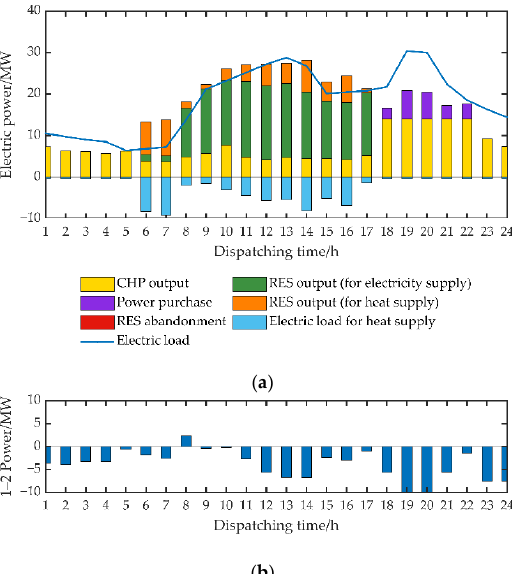
Figure 12. Dispatching strategy of the commercial area under joint dispatching: ( a ) Electric power of the commercial area; ( b ) Electric power of the tie line. The joint dispatching of the office area is shown in Figure 13, which is similar to that the office area is significantly reduced compared with that under independent dispatch- ing, and there is only a small amount of purchased electricity from 18:00 to 22:00.